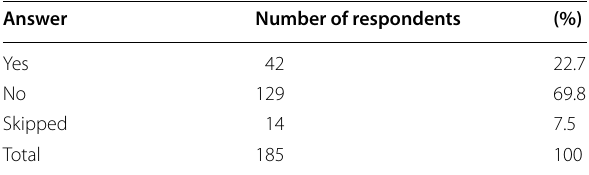
Table 11 Experience of 185 respondents with AI-based algorithms for clinical diagnostic interpretive tasks: Has (have) the algorithm(s) used for diagnostic assistance proven to be helpful in reducing the workload for the medical staff?